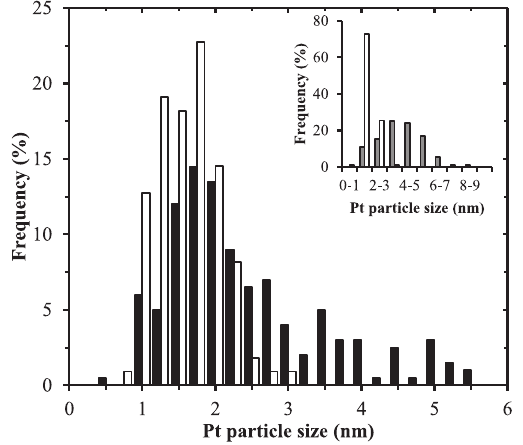
Fig. 11 Particle size distribution derived from TEM image processing for Pt nanoclusters deposited onto the TiO 2 support after 1 ALD cycle (white bars) and 5 ALD cycles (black bars). The inline graph shows the particle size distribution of the 1 ALD cycle Pt/TiO 2 (1.6 wt.%, white bars) and of a Pt/TiO 2 catalyst prepared via pho- todeposition (1.5 wt.%, grey bars) (Colón et al., 2010).